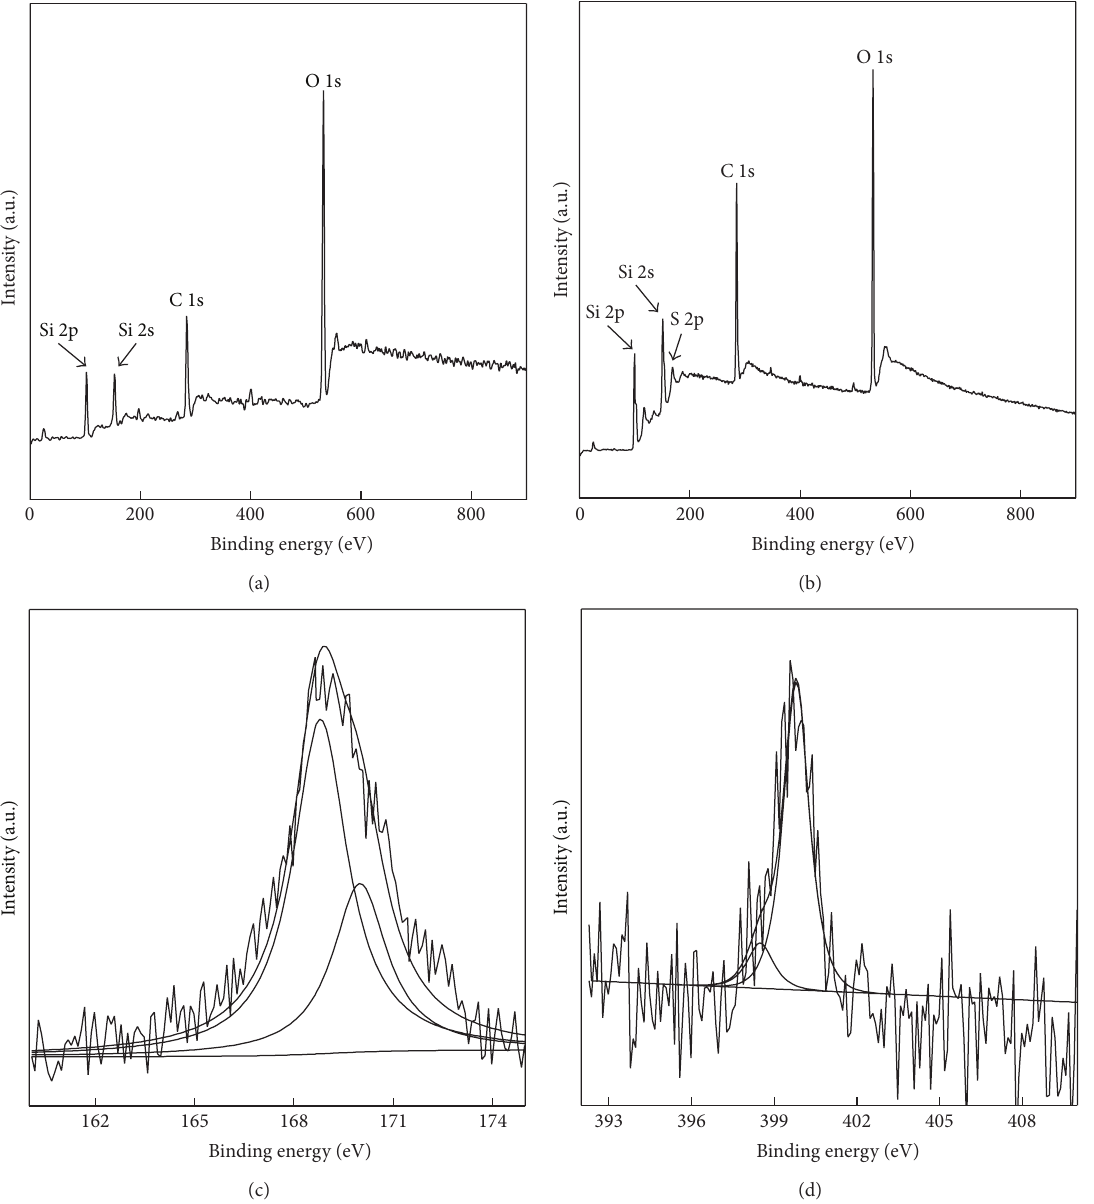
Figure 4: Survey XPS spectra of amino-modified MSNs (a); heparin-modified MSNs (b); XPS S 2p spectrum of heparin-modified MSNs (c); XPS N 1s spectrum of heparin-modified MSNs